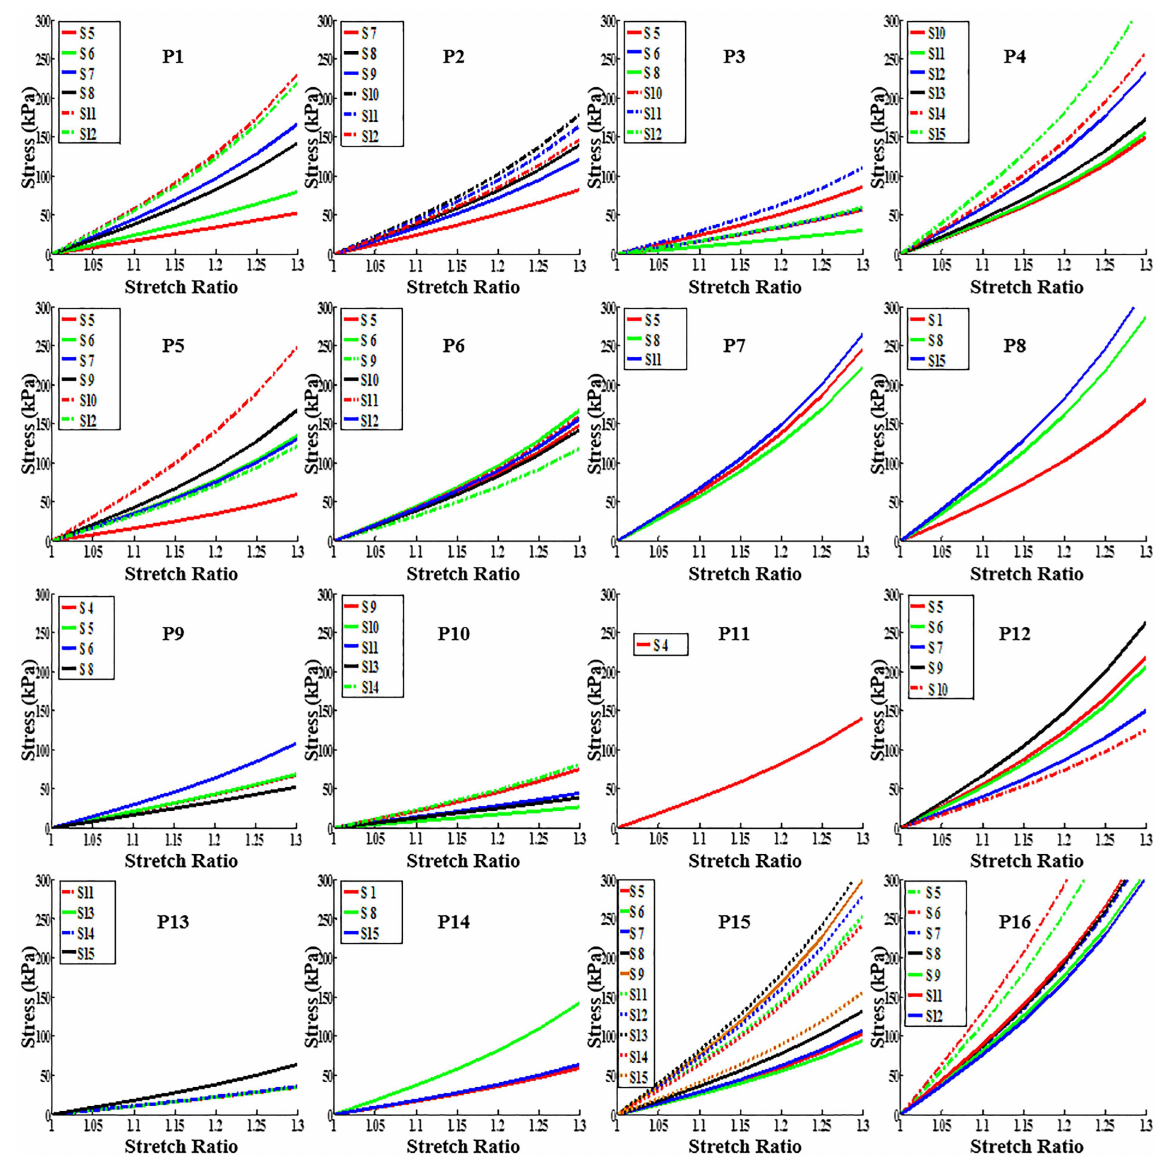
Fig 5. Stress-stretch curves from Mooney-Rivlin Models using parameter values determined from Cine MRI for the 16 plaque samples studied.